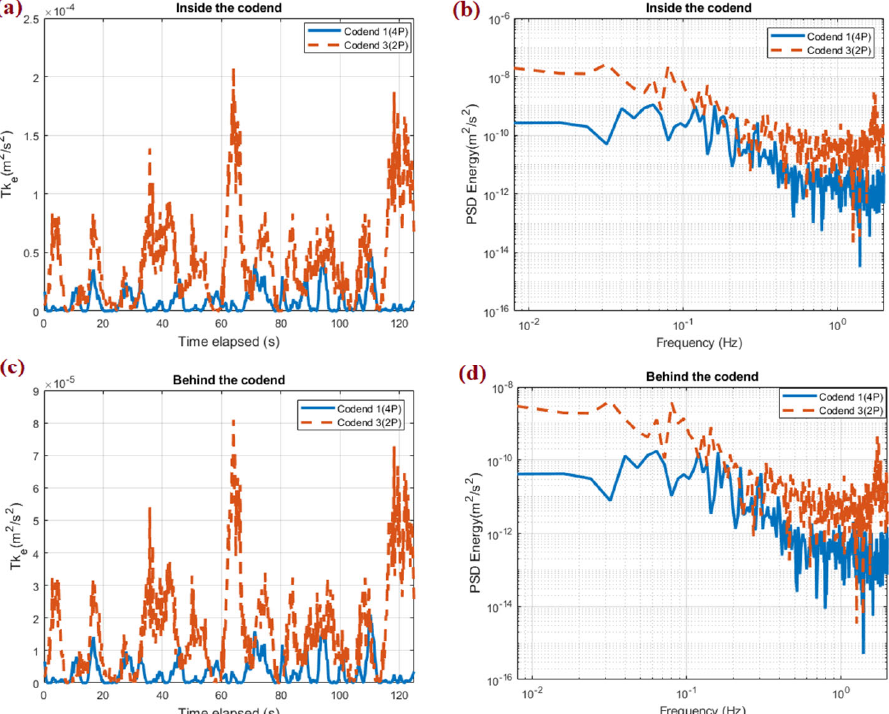
Figure 15. Time evolution of the TKE ( a ) inside and ( c ) behind the different codends linked to the normalized frequency spectrum energy (left in a log-log scale) ( b ) inside and ( d ) behind the different codends.